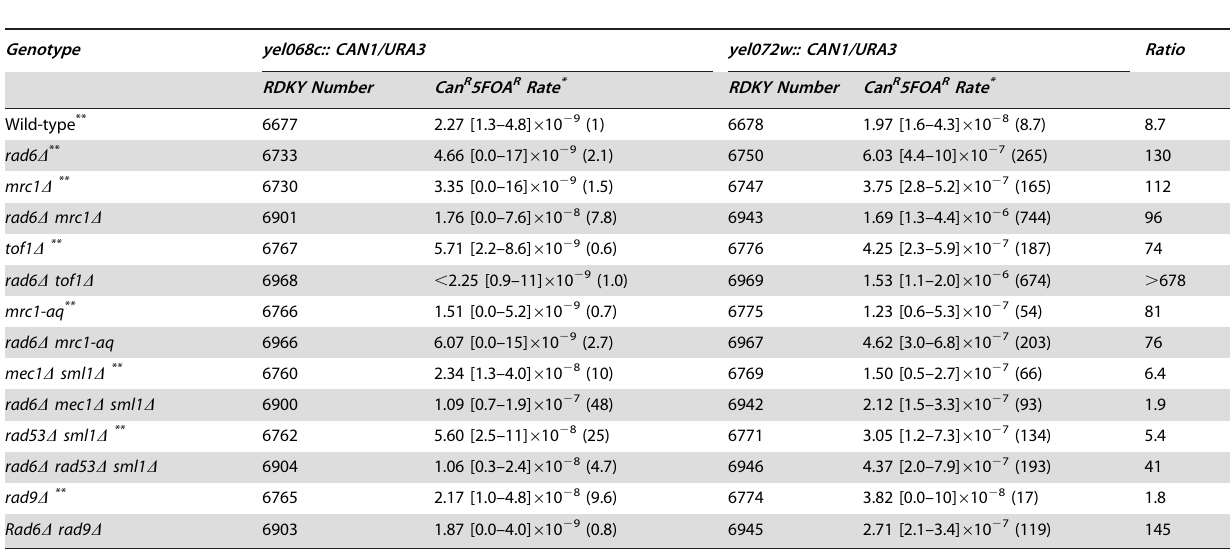
Table 1. Effects of combining RAD6 and checkpoint gene mutations on duplication-mediated GCRs.